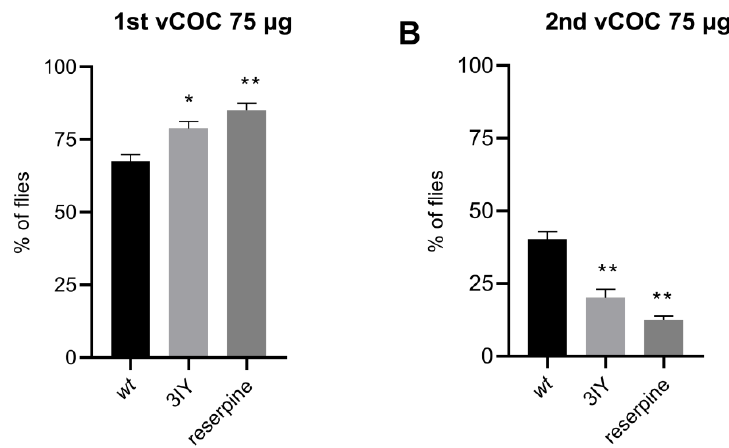
Figure A3. Dopamine modulates sensitivity and locomotor sensitization to vCOC. wt flies without